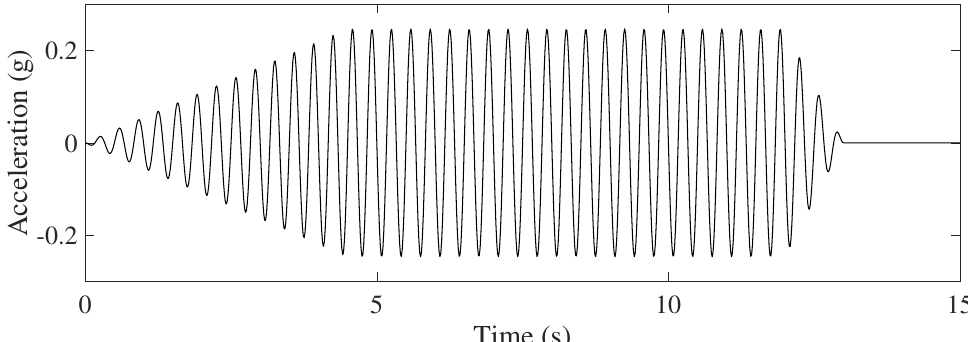
Figure 7. Applied shake to the base wall of the granular